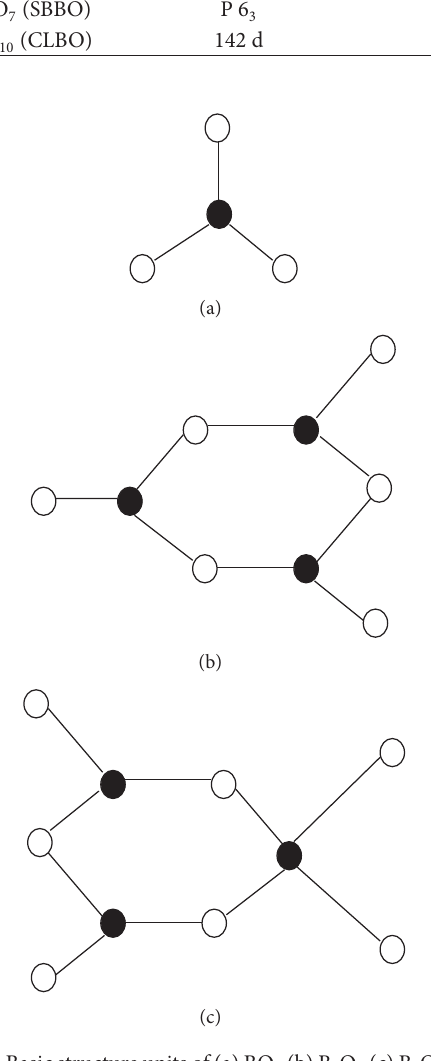
F 1: Basic structure units of (a) BO borates (dark circles represent boron and bright circles represent oxygen